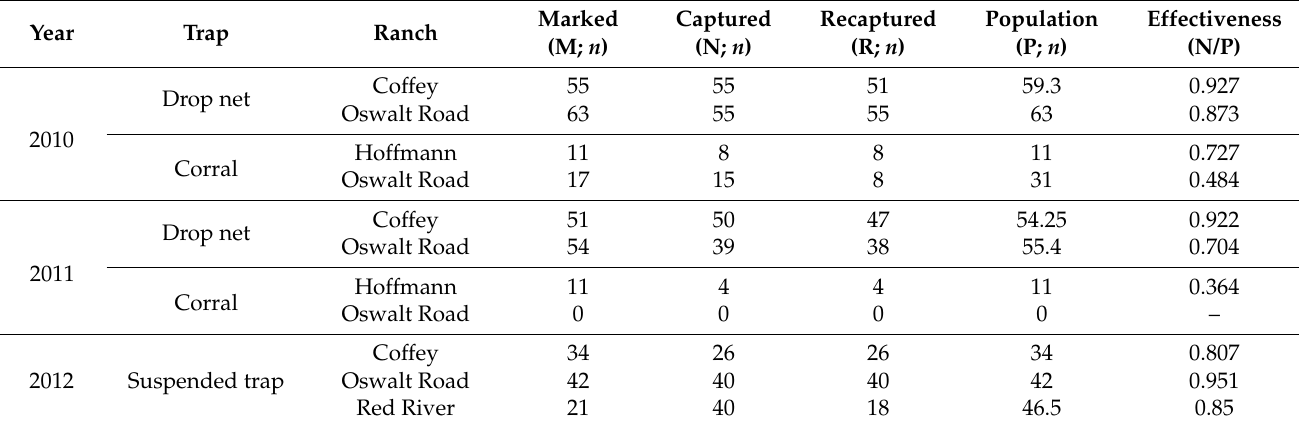
Table 1. Trap effectiveness for capturing wild pigs ( Sus scrofa ) by ranch for each trap type (drop net, corral trap and sus- pended trap) and year (2010–2012) on Coffey, Hoffman, Oswalt Road, and Red River ranches, Love County, Oklahoma,